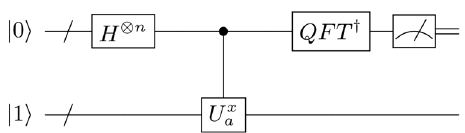
Figure 1. Schematic of the routine used for the period finding part of Shor’s algorithm. The first (control) register has n qubits. The number of qubits in the control register determines the bit-accuracy of the value of 2 n s / r . The bottom (work) register has the m qubits required to encode N . First, the control and work